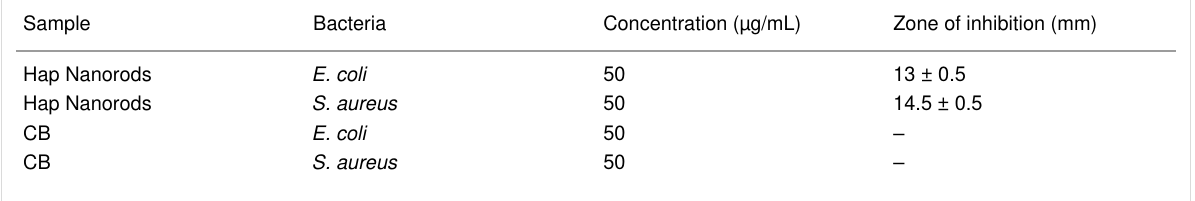
Table 1: Zone of inhibition of cuttlefish bone (CB) and hydroxyapatite (Hap) nanorods using cuttlefish bone powder as a precursor (CB-Hap NRs) towards gram-positive ( S. aureus ) and gram-negative ( E. coli ) bacteria.